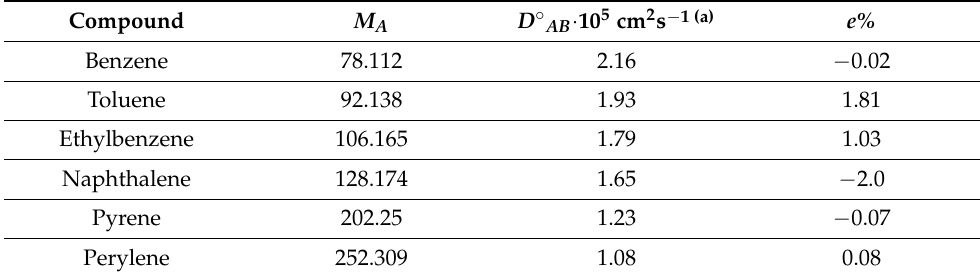
Table 4. Comparison of the D° AB ‐ values for compounds with the relative molecular mass M A , cal ‐ culated with Equation (29) with experimental data from [10]. Solvent n ‐ decane, M B = 142 at 25 °C.